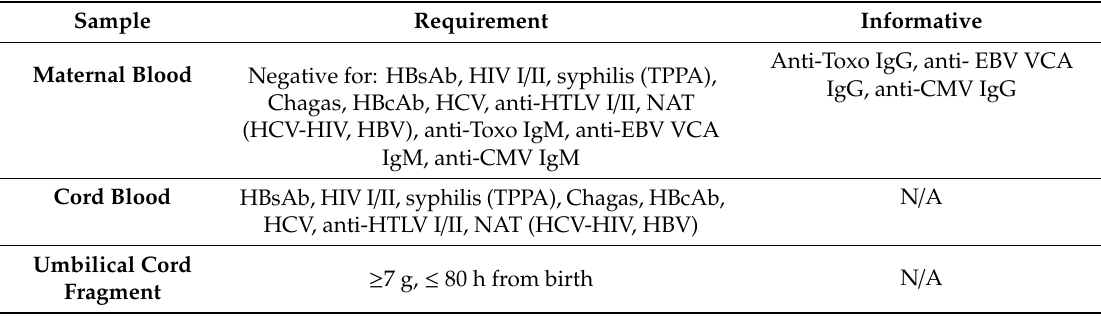
Table 1. Acceptance criteria of starting material.